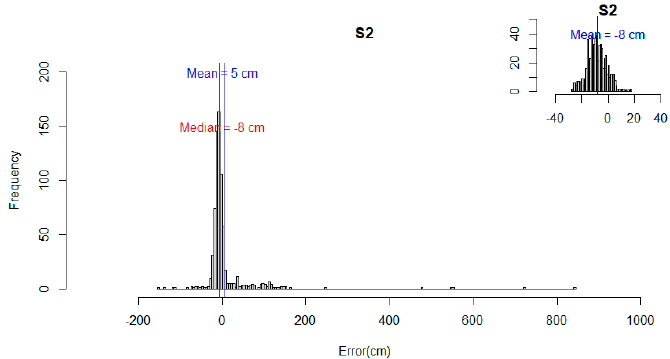
Figure 8. Histogram showing distribution of error of S2. Inset plot shows data distribution when outliers are removed.